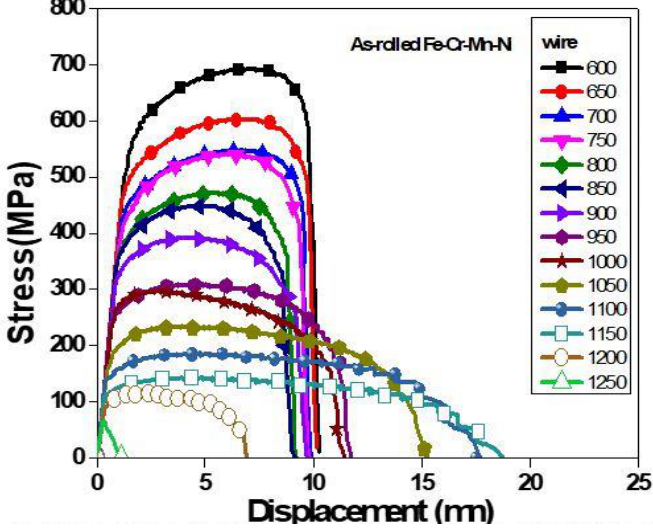
Figure 6. Stress-stroke displacement curves of grove-rolled high-carbon high-nitrogen Fe-Cr-Mn-Ni austenite stainless steel.